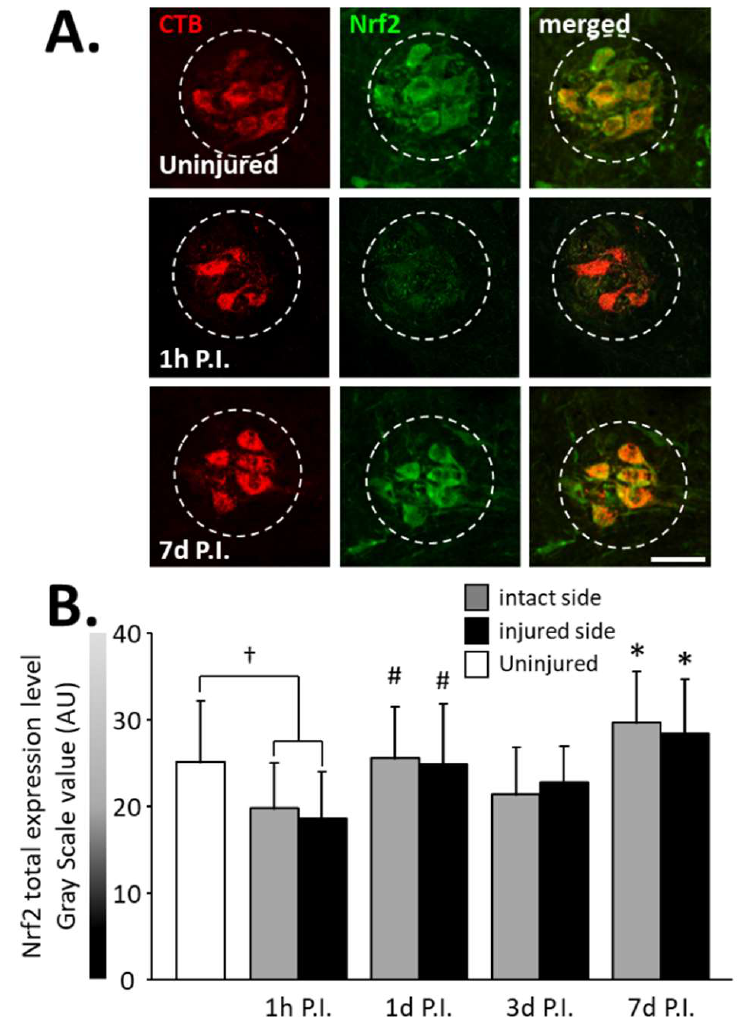
Figure 5. Nrf2 expression in phrenic motoneurons following C2 hemi-section. ( A ) Representative images showing expression of Nrf2 in phrenic motoneurons labeled with CTB in uninjured animals and in denervated phrenic motoneurons in C2 hemisected rats, 1 h and 7 d post-injury (P.I.). ( B ) Quan- tification of Nrf2 in phrenic motoneurons for uninjured animals, and intact and injured sides of C2 hemisected animals 1 h, 1 d, 3 d, and 7 d following injury. # Compared to 1 h P.I. group, p < 0.05. * Compared to uninjured group and 1 h P.I. corresponding side, p < 0.05. † Uninjured compared to 1 h intact side and injured side, p <